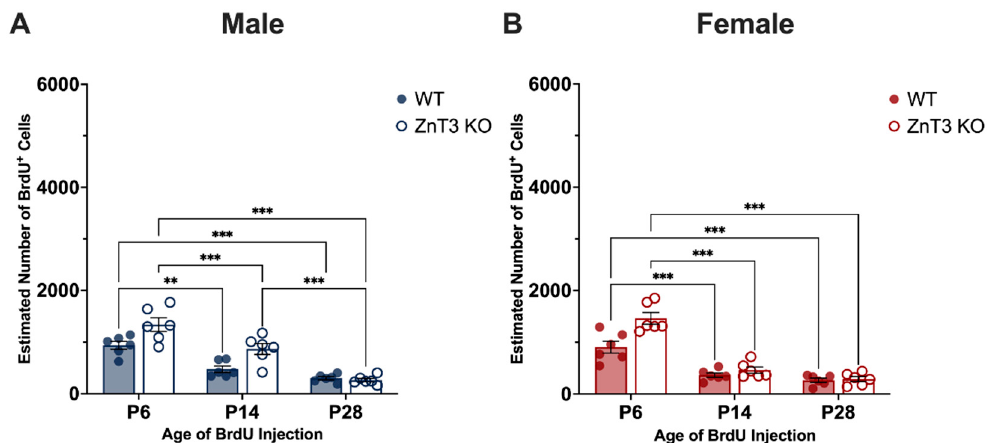
Figure 6. Age effects on cell survival, as measured by BrdU + cells at P60, in male and female WT and ZnT3 KO mice injected on P6, P14, and P28. BrdU was administered to male and female WT and ZnT3 KO mice on P6, P14, or P28 to label dividing cells ( n = 6 per group). To assess the cell survival, brains were collected on P60, and BrdU + cells were counted in the SGZ and GCL. ( A ) Male WT mice injected on P6 had significantly higher numbers of BrdU + cells that remained at P60 compared to male WT mice injected on P14 and P28. Similarly, male ZnT3 KO mice injected on P6 also had significantly higher numbers of BrdU + cells that remained at P60 compared to male ZnT3 KO mice injected on P14 and P28. In addition, higher levels of BrdU + cell survival were also observed in male ZnT3 KO mice injected on P14 relative to mice injected on P28. ( B ) Female WT and ZnT3 KO mice injected on P6 displayed significantly higher levels of BrdU + cell survival at P60 compared to mice injected on P14 and P28. Error bars represent ± standard error of the mean. ** Indicates p < 0.010; *** indicates p < 0.001.